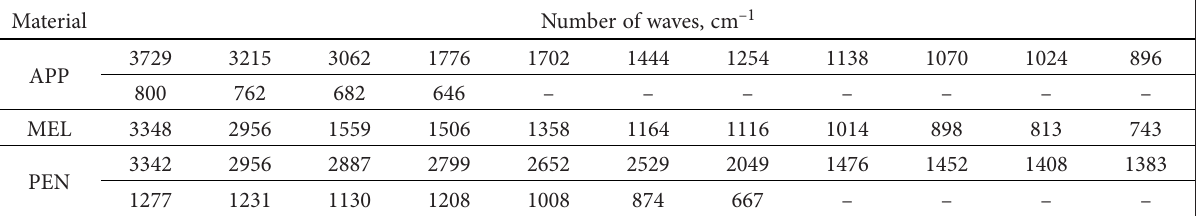
Table 4. The number of waves of intumescent fire protective coatings by the main components